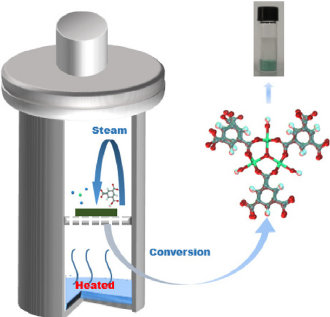
Figure 4. A schematic diagram of steam-assisted conversion of MIL-100(Cr) [44].